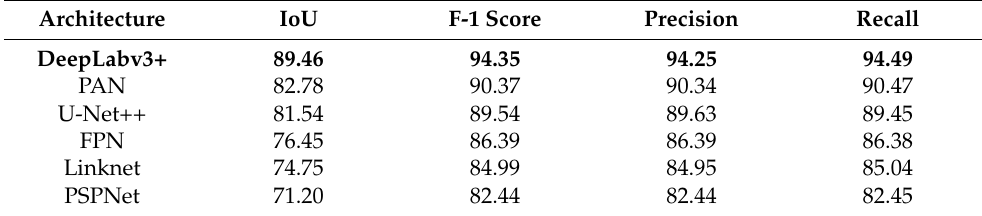
Table 2. Comparison of segmentation results of different architectures (bold font indicates the best performing setup).